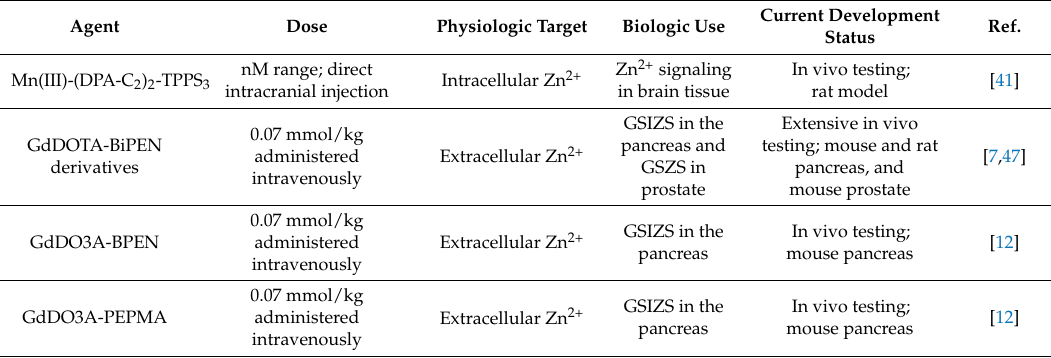
Table 1. Selected responsive contrast agents (mostly T 1 ), dosages, biologic use, and current development level. Several agents have made the successful transition to in vivo imaging. Physiologic